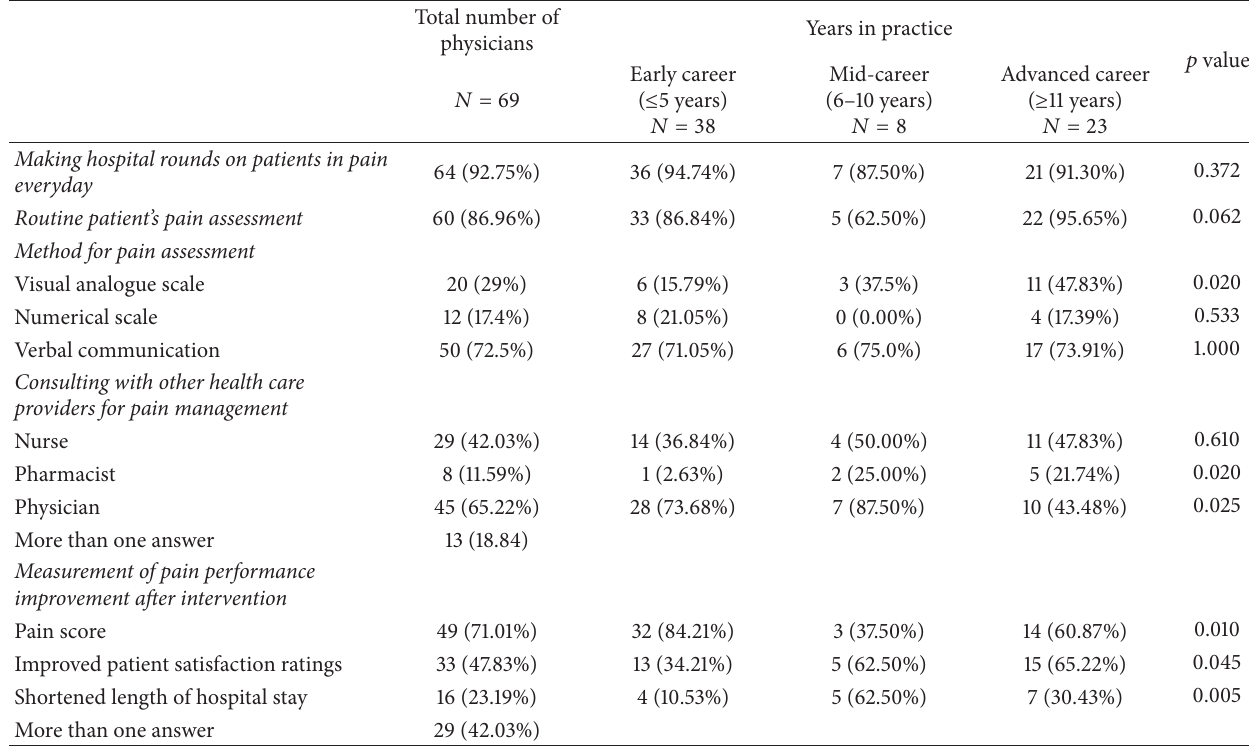
Table 3: Physicians’ approach to pain management based on years in practice.